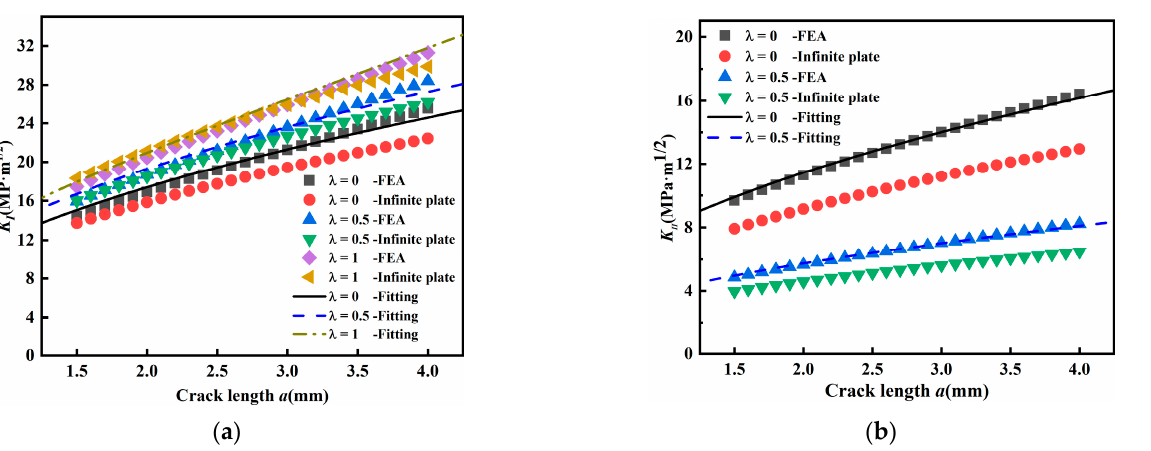
Figure 5. Stress intensity factor versus crack length a ( β = 60°). ( a ) Relationship between K I and a and ( b ) relationship between K II and a .